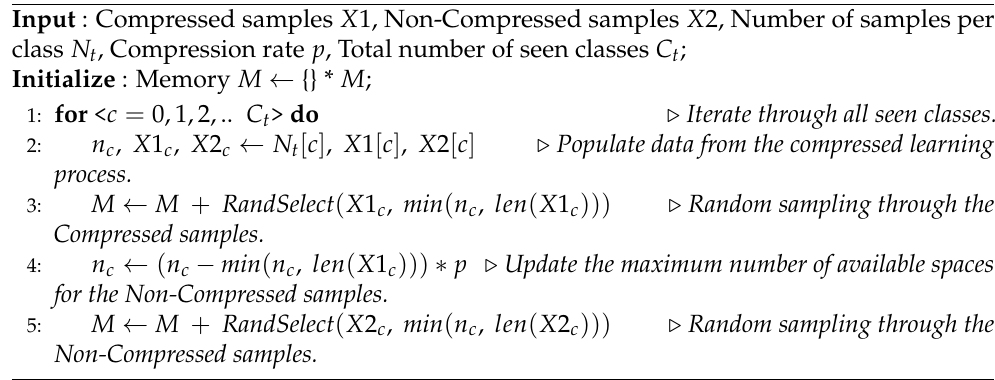
Figure 4. The Cutout-CL pipeline for generating compressed samples and selecting noncompressible samples. Algorithm 2 Compressed learning memory